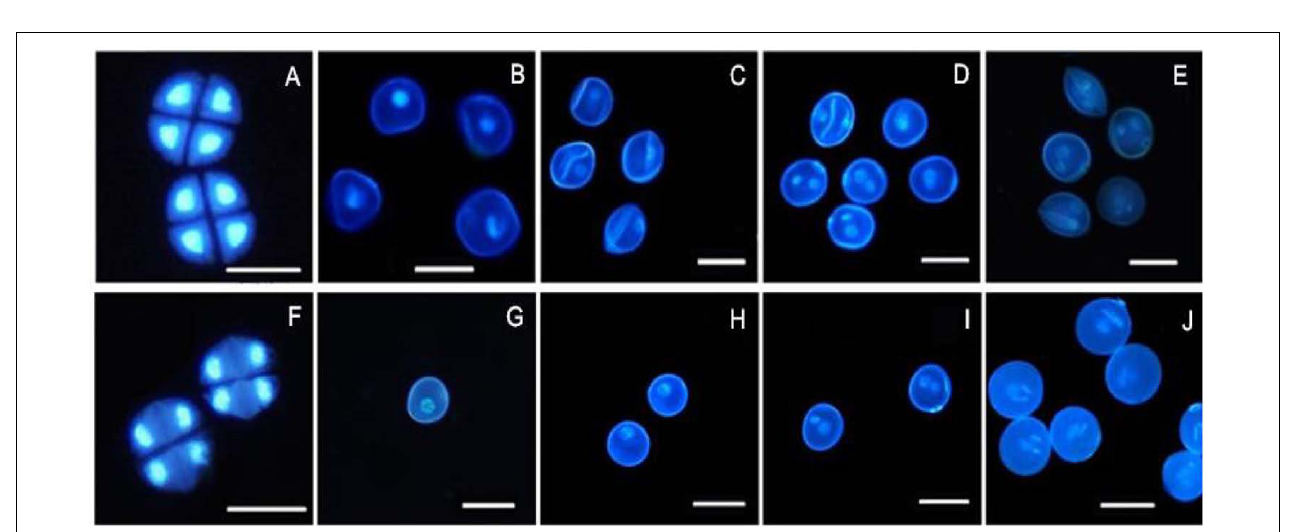
FIGURE 1 | Comparison of plant anther and pistil external morphological characteristics and I2-KI staining of KTM3315A under the different fertility condition (AS: A–G, AF: H–N). (A,H) Tetrad stage; (B,I) early uninucleate stage; (C,J) the later uninucleate stage; (D,K) the binucleate stage; (E–G,L–N) the trinucleate stage. (A–F,H–M) Bar: 1000 µ m; (G,N) Bar: 50 µ m.